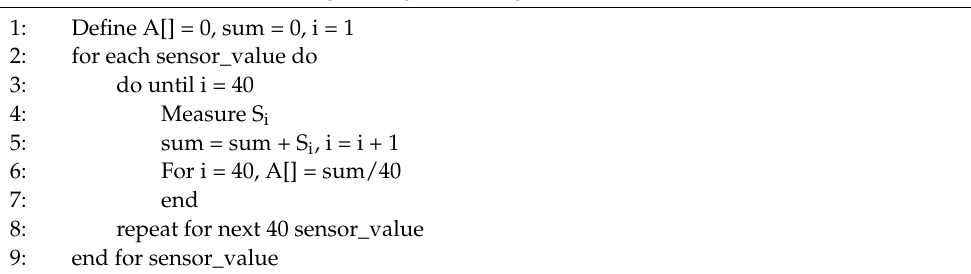
Algorithm 1: 40 Points—Moving Average Filter Algorithm